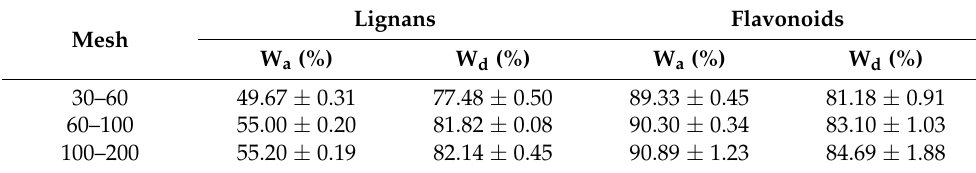
Table 2. Results of static adsorption and desorption experiments with